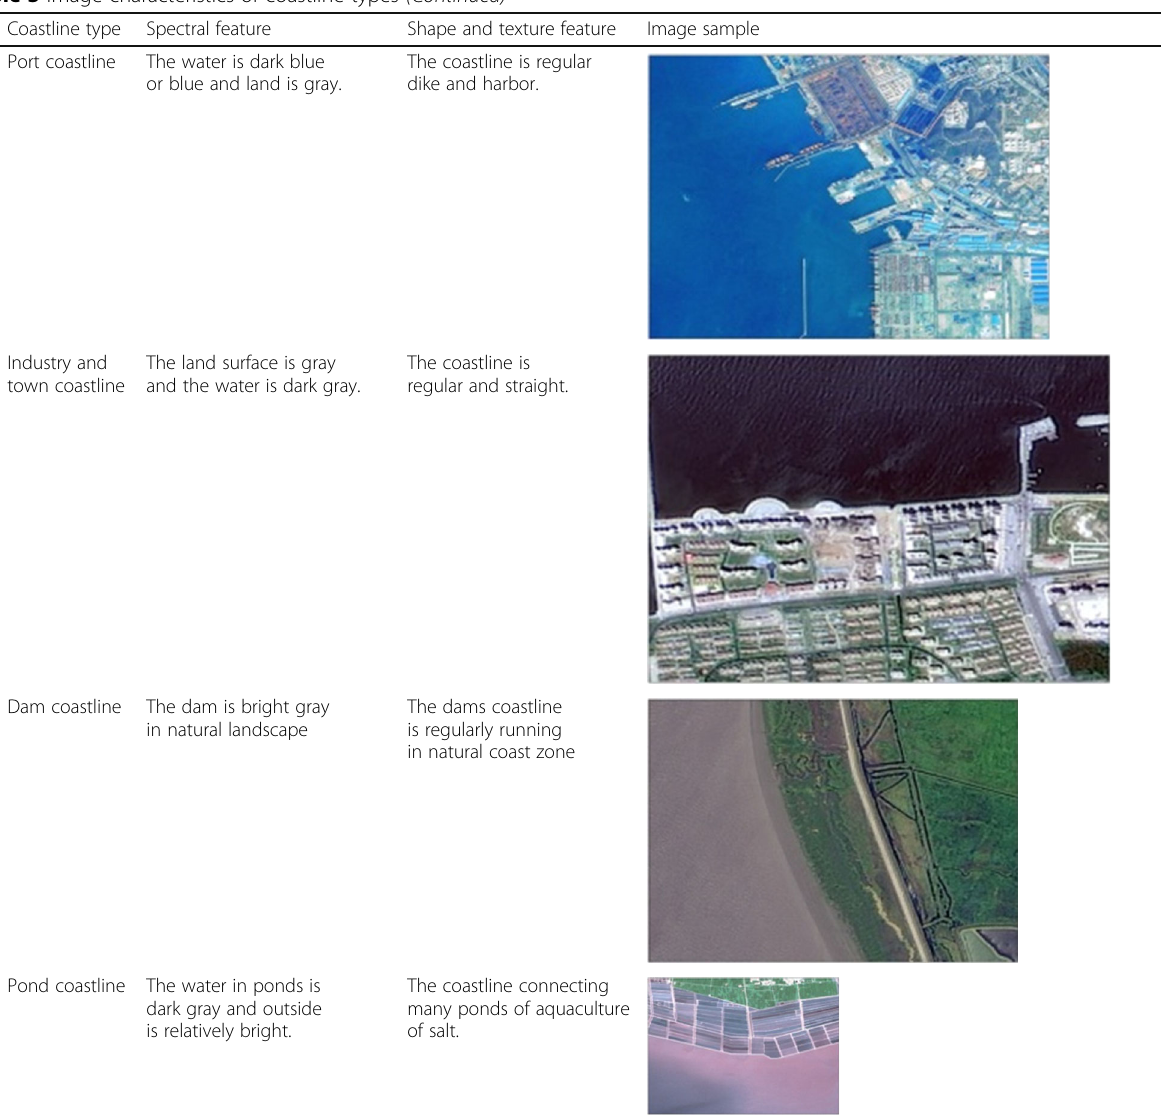
Table 3 Image characteristics of coastline types